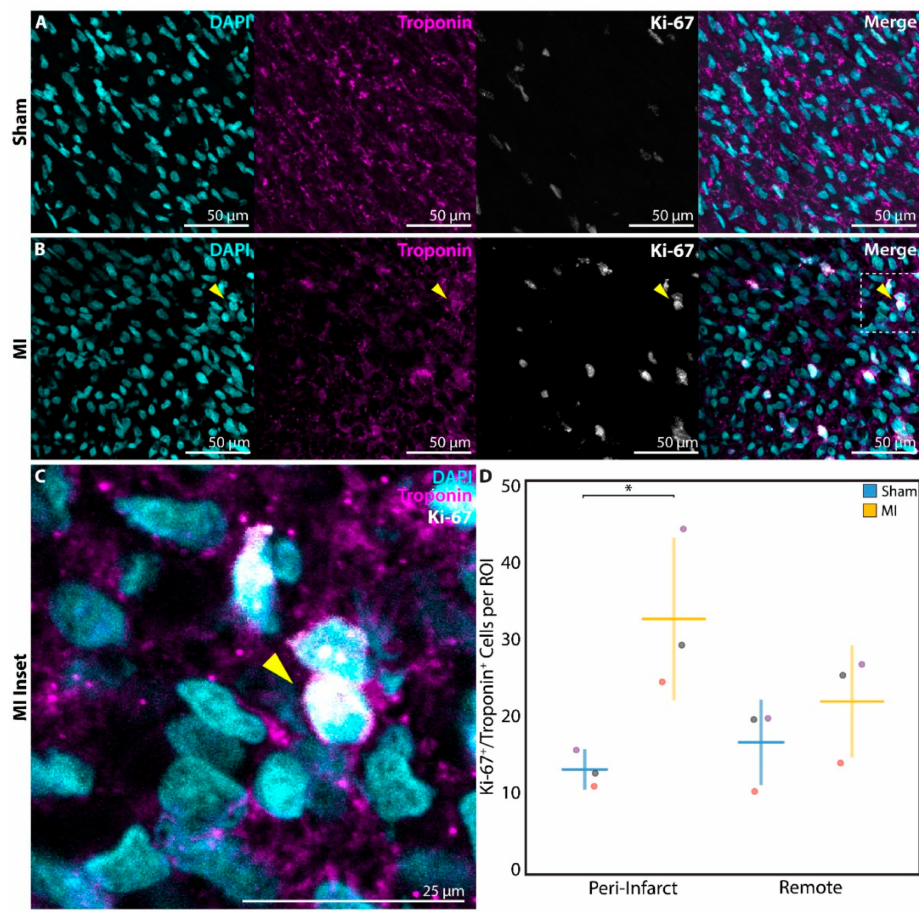
Figure 6. Assessment of cardiomyocyte proliferation using Ki-67 at 1 week after sham surgery ( n = 3) or induction of myocardial infarction (MI, n = 3) on postnatal day 1 (P1). Ki-67 + / troponin + cardiomyocytes were detected within the peri-infarct region after ( A ) P1 sham and ( B ) P1 MI surgery. Inset ( C ) focuses on one Ki-67 + / troponin + cardiomyocyte after P1 MI, marked by the yellow arrow. ( D ) Significantly more Ki-67 + / troponin + cardiomyocytes were detected within each region of interest (ROI) for the P1 MI group compared to the P1 sham group in the peri-infarct region. * indicates p < 0.05. Horizontal lines indicate mean. Vertical lines indicate standard